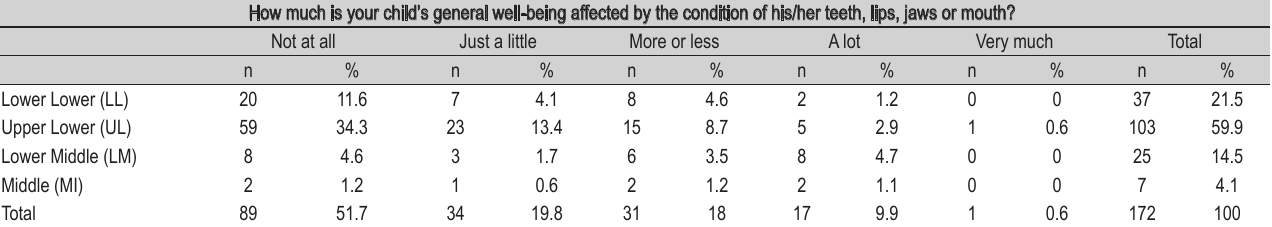
Table 2 - Number and percentage of parents or guardians according to the perception of the general well-being due to their children’s oral health and socioeconomic classes, Américo de Campos/Pontes Gestal, Brazil, 2015.